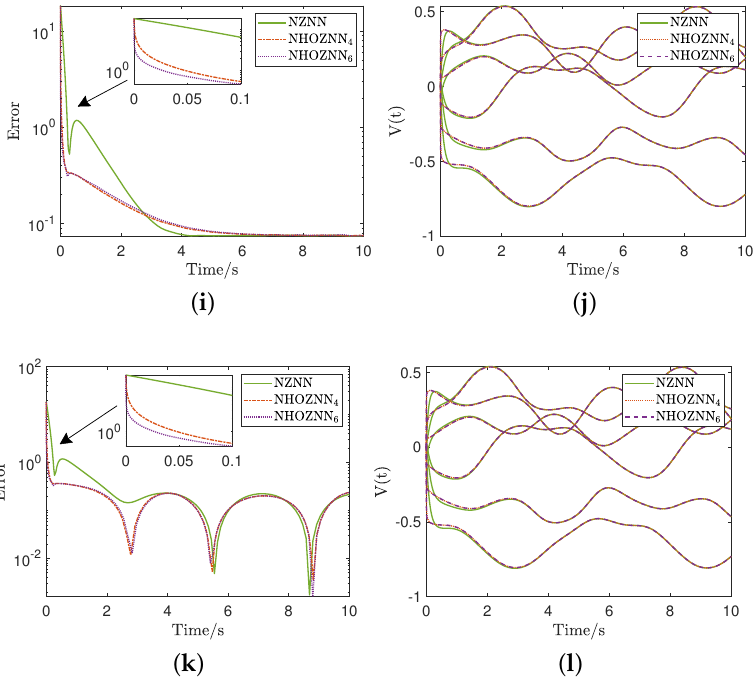
Figure 2. Trajectories of the HOZNN’s solutions and convergence in NEs Sections 4.1 and 4.2 with CN, LN, and BRN. ( a ) NE Section 4.1 with CN: convergence. ( b ) NE Section 4.1 with CN: